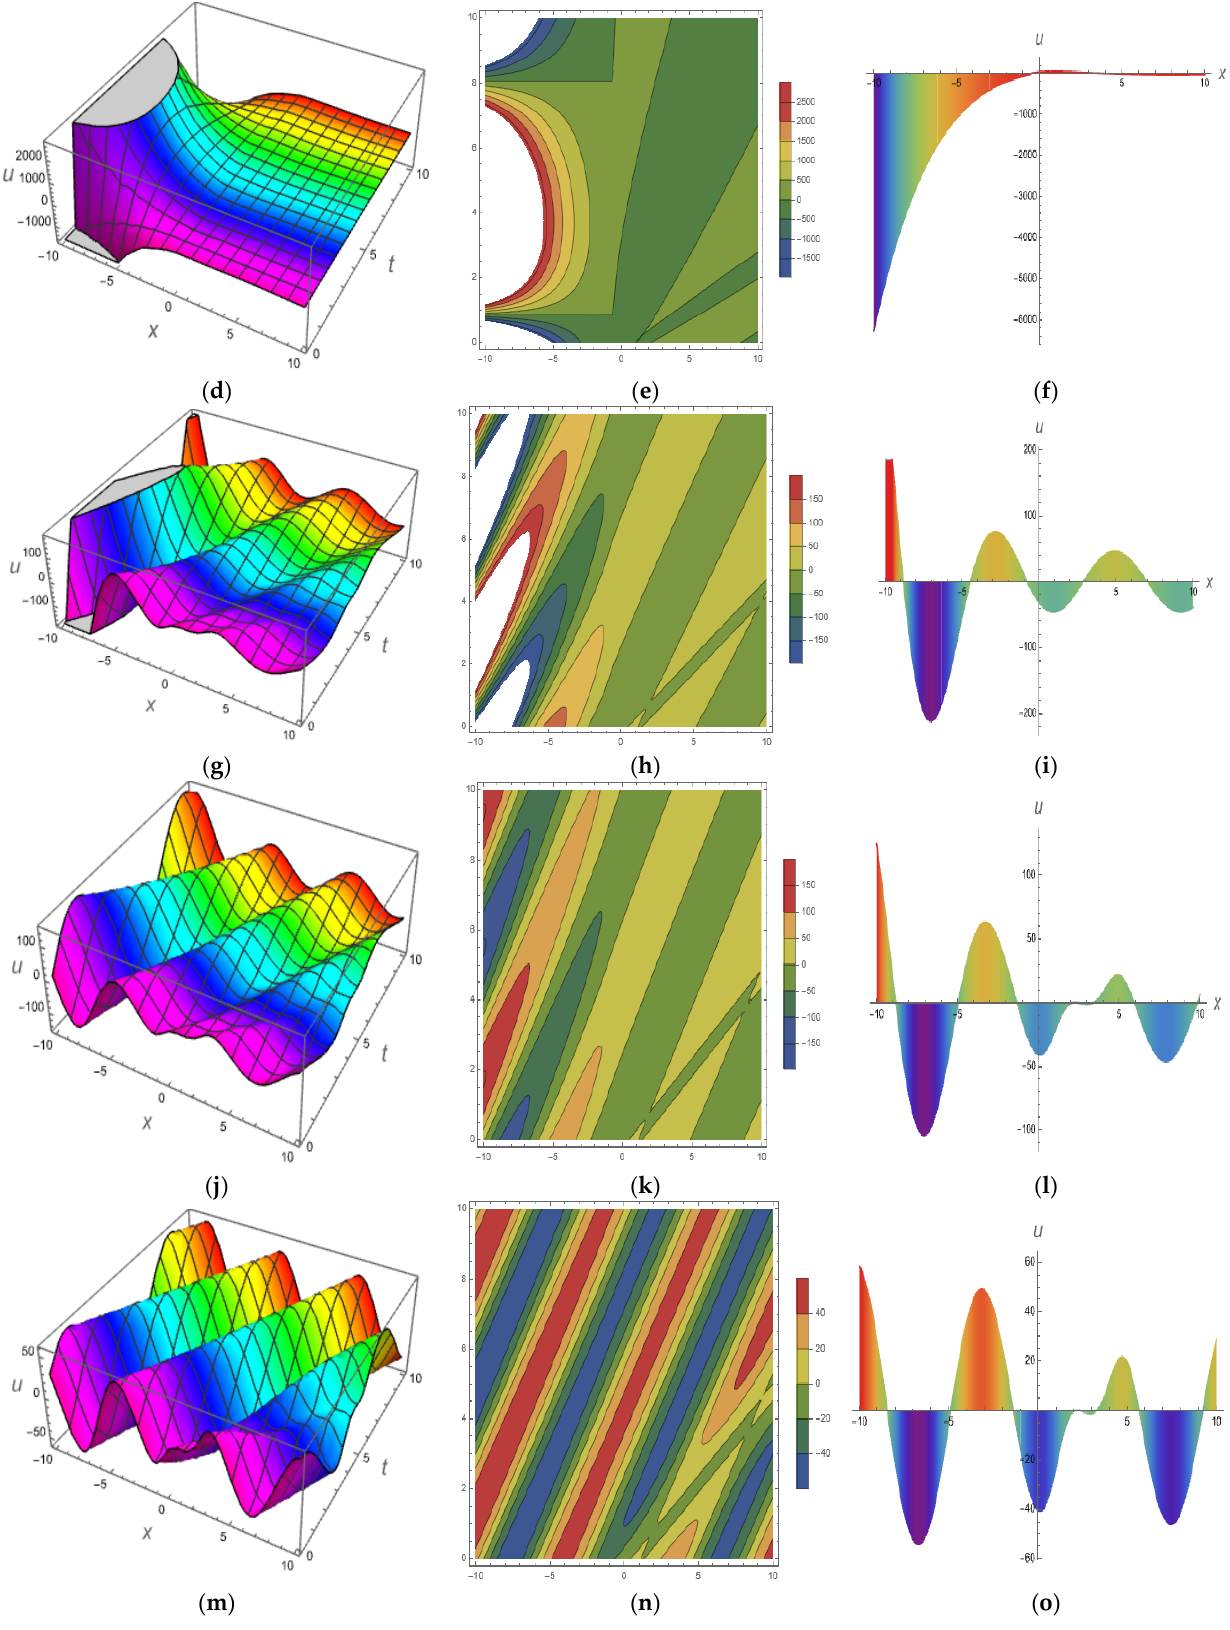
Figure 3. This figure presents the impact of fractional order on the solution Im g ( U 1,1 ( x , t )) at a = 1,w = 0.9, P = 0.9, k = 0.9, c = 1, N = 0.7, a 0 = 2, a 2 = 11.56449544 I , ν = 0.1. ( a ) 3D